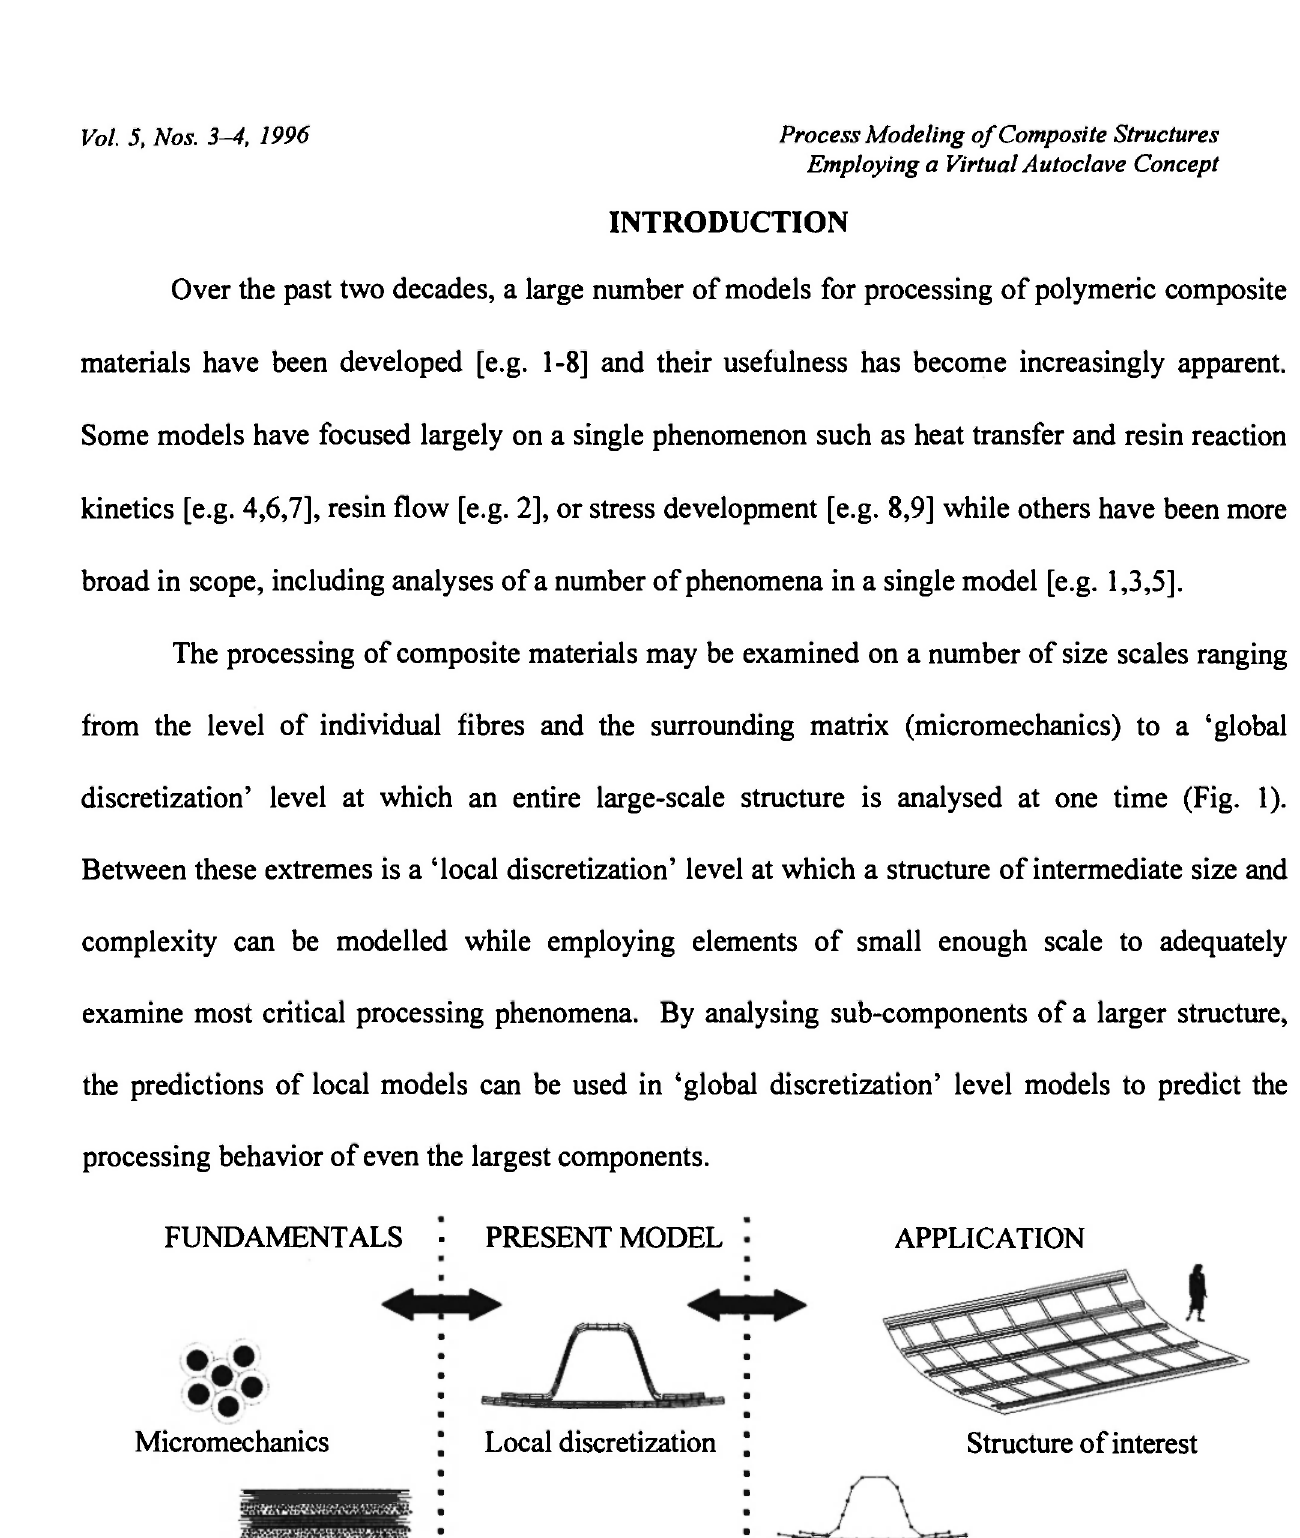
Figure 1 Range of scales of interest in modelling the processing of composite